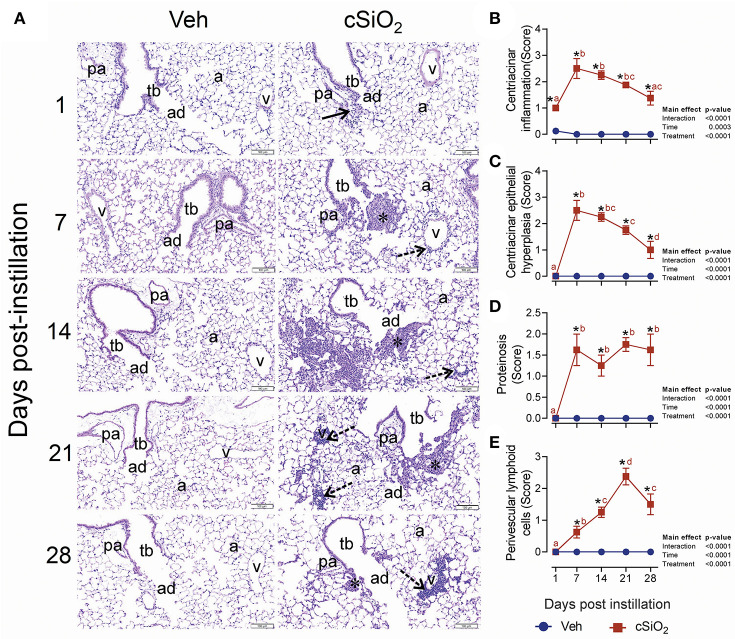
Intranasal instillation with 2.5 mg cSiO2 induces persistent lung inflammation in NZBWF1 mice. (A) Representative light photomicrographs of hematoxylin and eosin-stained lung tissues (centriacinar regions) from mice intranasally instilled with Veh or 2.5 mg cSiO2 and sacrificed after 1, 7, 14, 21, and 28 d PI. Acute, neutrophilic inflammation was present in the centriacinar regions (solid arrows) after 1 d PI in cSiO2-treated mice. Centriacinar granulomatous inflammation (foci composed of macrophages, hyperplastic epithelial cells, neutrophils, and lymphocytes; asterisks) was present in cSiO2 exposed mice after 7 and 14 d PI but waned in severity by 21 and 28 d PI. Perivascular infiltration of lymphocytes, especially around pulmonary veins (v; stippled arrows) increased in severity from 7 to 28 d after cSiO2 exposure, especially at 28 d PI. pa, pulmonary artery; tb, terminal bronchiole; ad, alveolar duct; a, alveolar parenchyma; v, pulmonary vein. Semi-quantitative scores for: presence of (B) centriacinar inflammation, (C) centriacinar epithelial hyperplasia, (D) alveolar proteinosis, and (E) perivascular lymphoid cells. Scoring was as follows: 0—no significant finding, 1—minimal, 2—mild, 3—moderate, 4—marked, 5—severe. Data are presented as mean ± SEM (n = 8). Asterisk indicates significantly different from time-matched Veh control (p < 0.05).